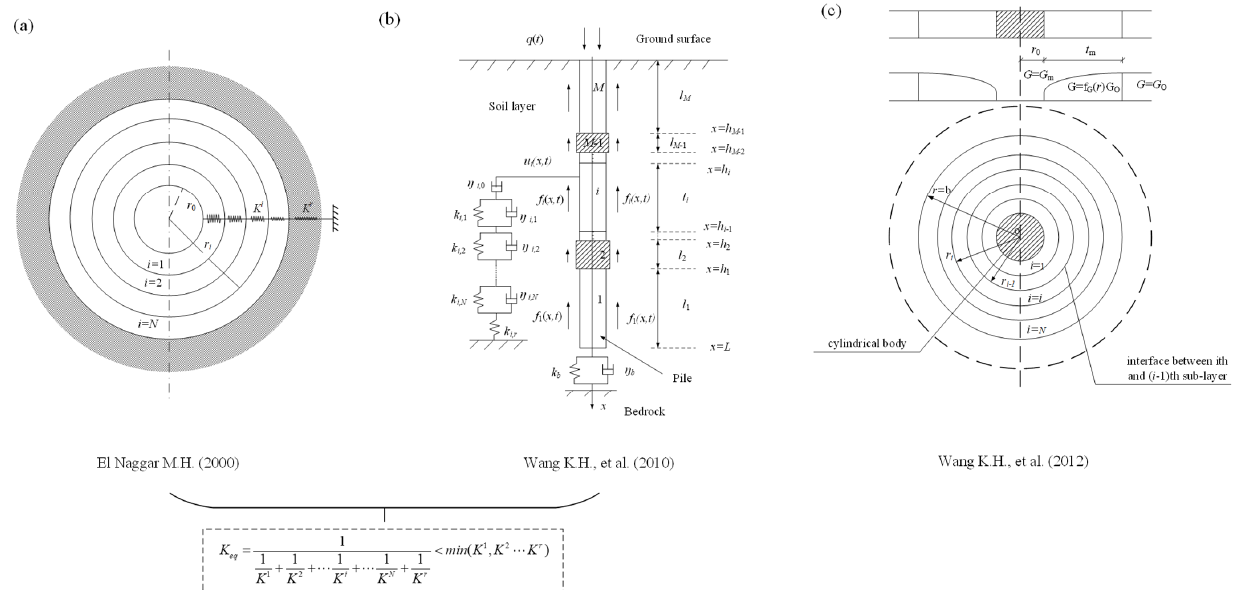
Figure 1. Advantages of plane strain model for modeling of the radial inhomogeneous problem: ( a ) tandem spring model [20]; ( b ) Voigt model in series [21]; ( c ) plane strain model [22]. However, the dynamic Winkler model is still an approximation to the rigorous answers